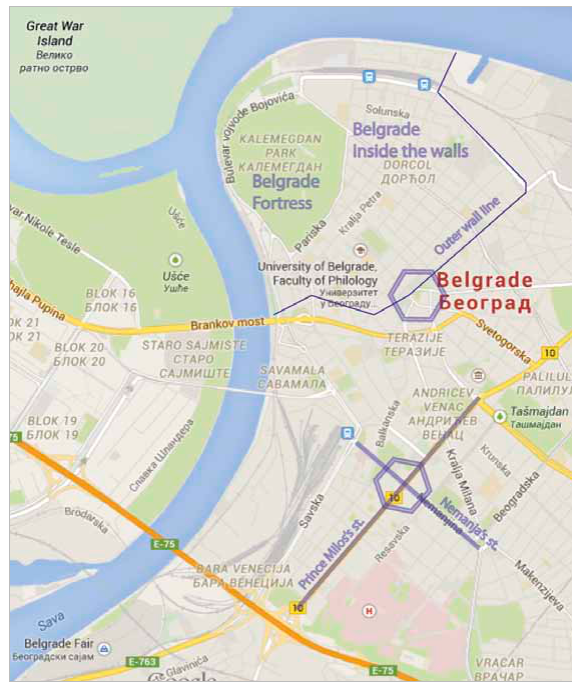
fig. 1. location of the intersection in the wider urban tissue of present day Belgrade. Source : Interventions of the author on the map available on Google